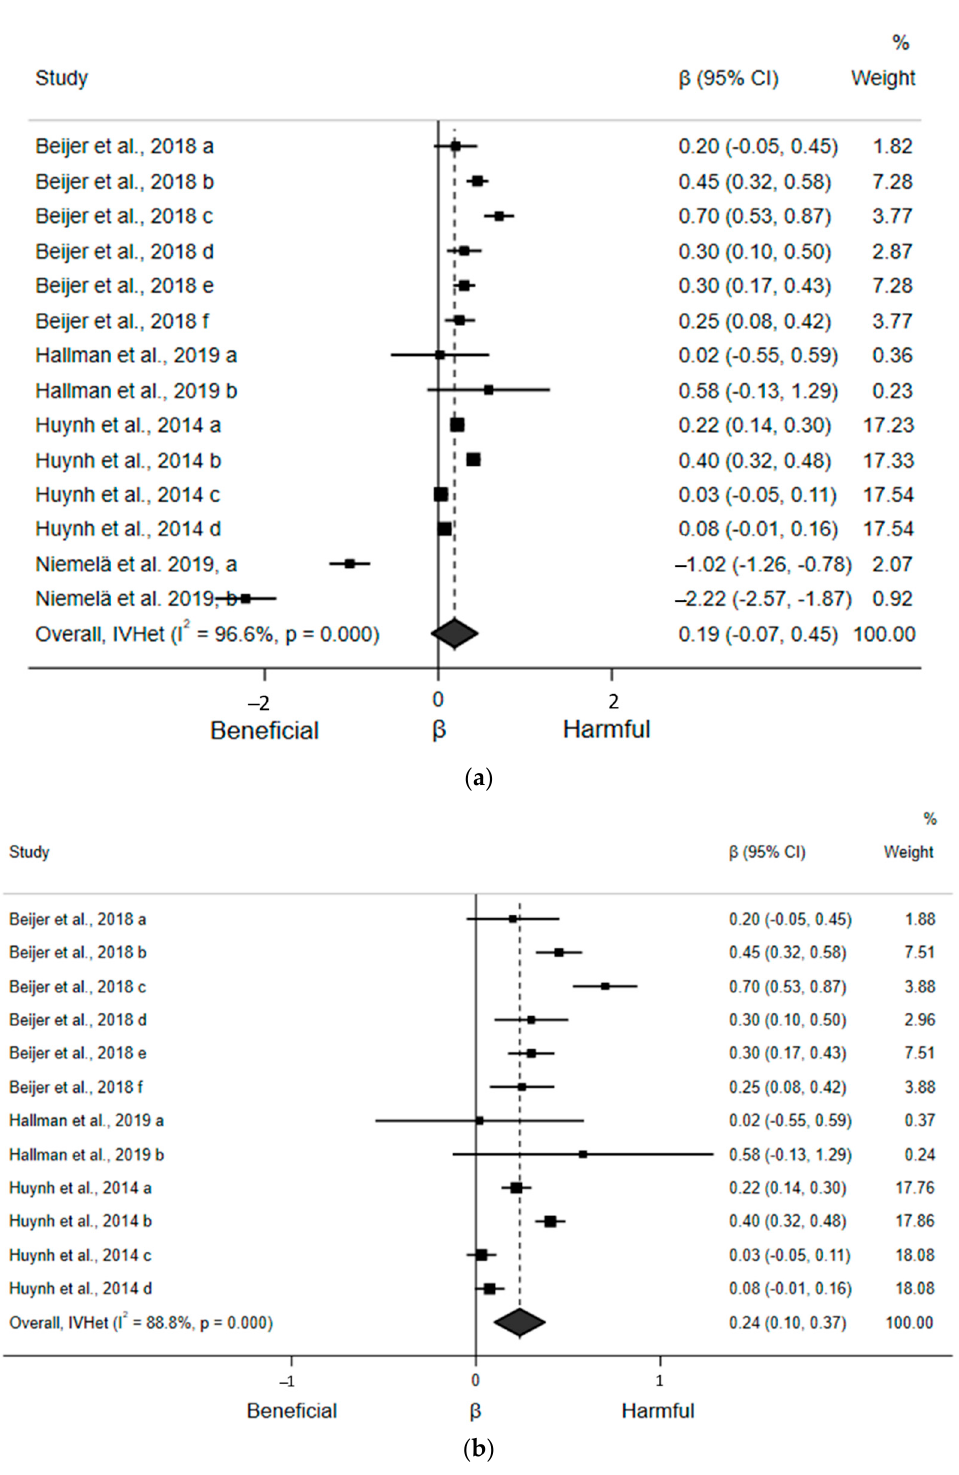
For the qualitative assessment, 80% ( n = 5) and 71% ( n = 7) of the estimates found no correlation between ST and SDNN and RMSSD, respectively. Because more than 50% of